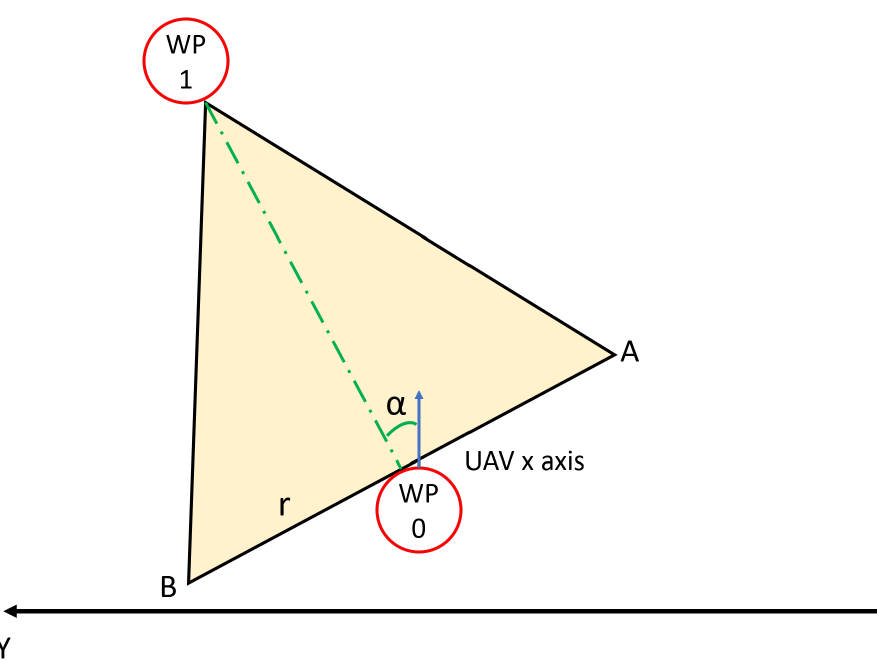
Figure 20. Limiting the scan area for precise navigation to a preset